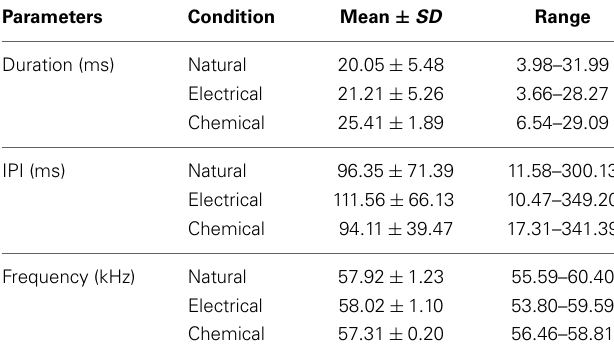
Table 1 | Parameters of echolocation pulses emitted under natural conditions and during stimulation at different